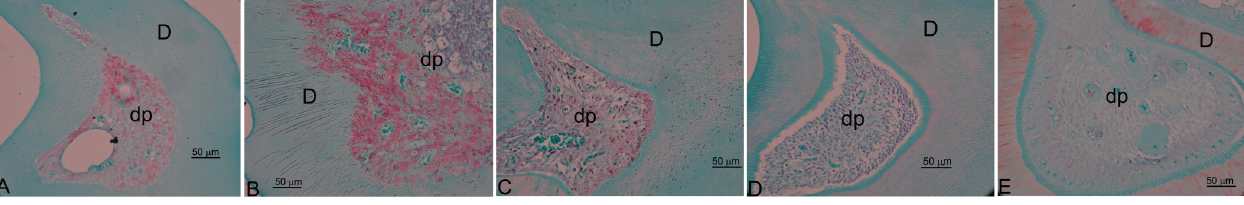
PLOS ONE | https://doi.org/10.1371/journal.pone.0250429 May 26,